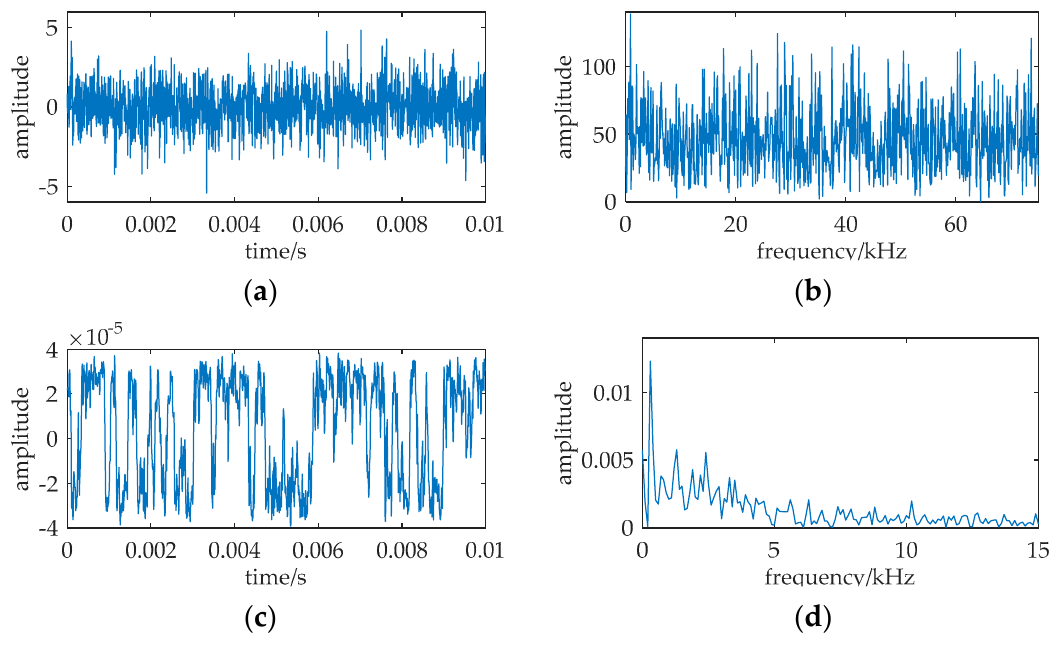
Figure 10. The numerical simulation results of MNSR. The relative parameters: A = 0.15, f = 37.5 kHz, a = 3×10 4 , b = 4.65×10 13 , f c = 37.8 kHz, D = 0.9, f s = 150 kHz, N = 1500. (a),(b) are the waveform and frequency spectrum of the input; (c),(d) are waveform and frequency spectrum of the MNSR output.